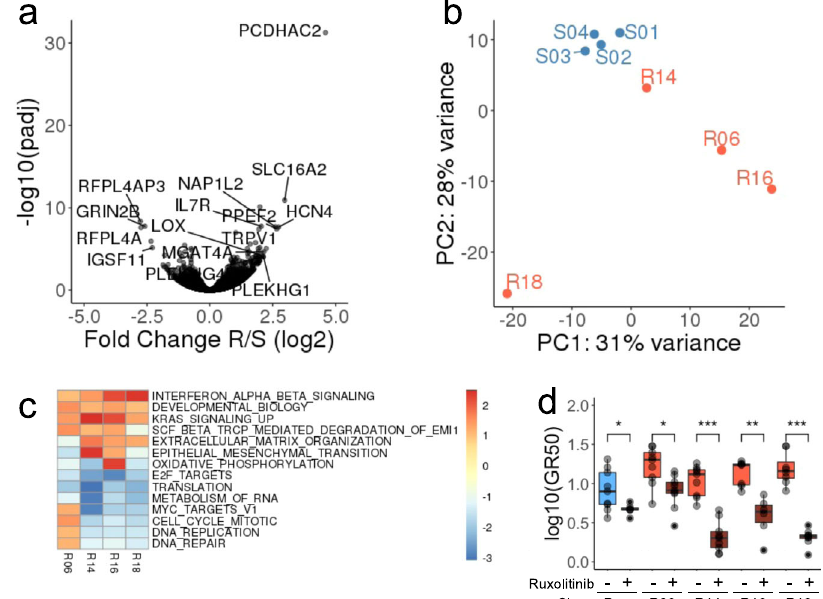
Fig. 2 Expression pro fi ling of the derived clones. a Volcano plot indicating the fold change ( y axis) and signi fi cance ( x axis) of the genes differentially expressed between S and R clones. b First two principal components derived from the expression pro fi les of each clone. c Most signi fi cantly up or down-regulated gene sets (Hallmark and Reactome from MSigDB) in individual R clones compared to all S clones. Signi fi cant gene sets ( q < 0.005) enriched (score > 1.5) or depleted (score < − 2) in at least one clone are reported. Color gradient indicates enrichment score. d Treatment with 5 µM ruxolitinib (Rux) signi fi cantly decreases the growth-rate corrected half maximal inhibitory concentration (GR50) in both Parental and R clones. The results of 3 dose-response experiments, 3 replicates per experiment are presented. Signi fi cance was measured using Wilcoxon Test (* < 0.05, ** < 0.01, *** < 0.001). Boxes represent the top and bottom quartiles of the distribution and whiskers are extended to 1.5 time the interquartile